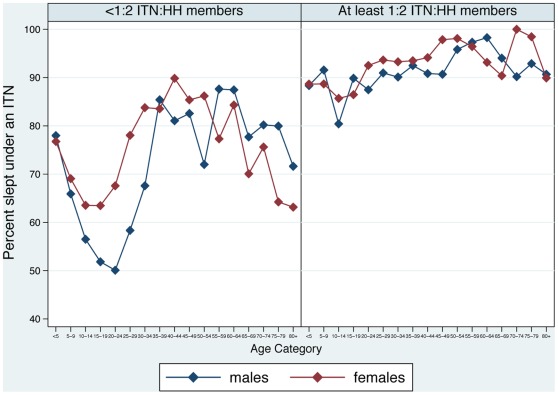
Among individuals in households with at least one ITN, percent who slept under an ITN the night before the survey, by intra-household access status, five-year age category, and gender, Sierra Leone, 2011.